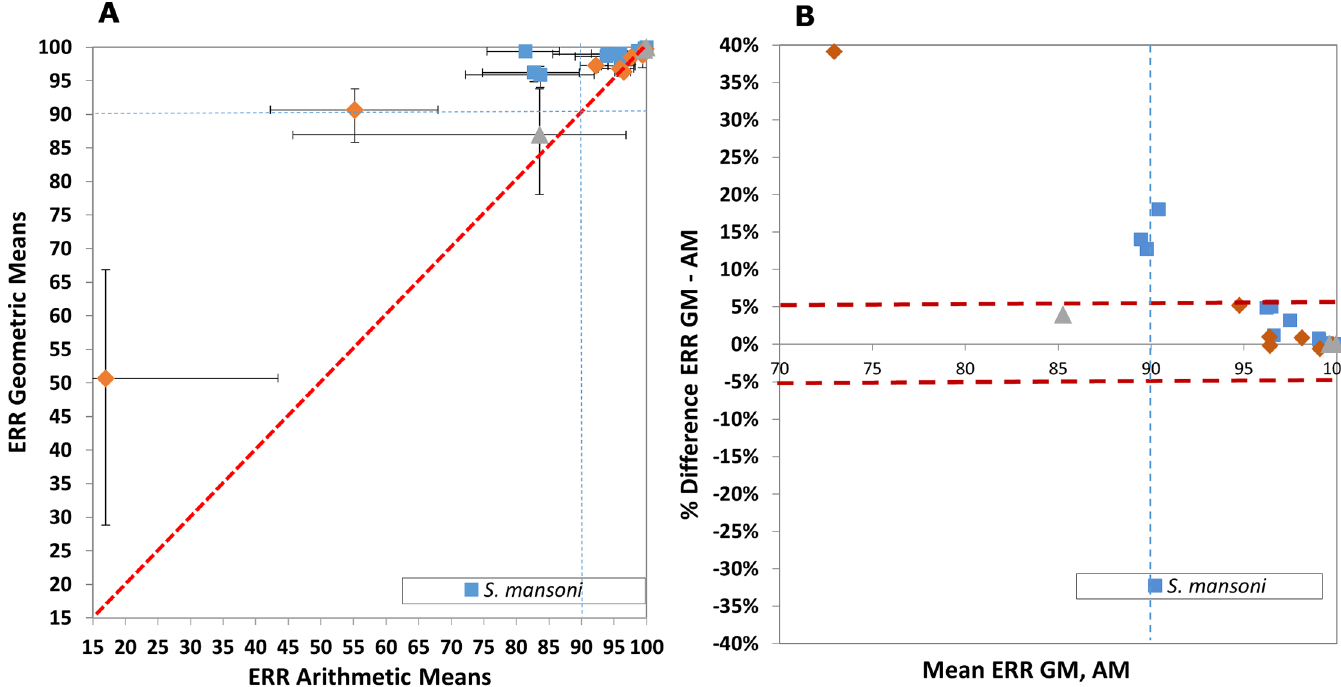
Fig 2. Comparison of egg reduction rate calculated as arithmetic mean (ERR AM ) versus geometric mean (ERR GM ), both with estimated 95% confidence intervals (CIs). A. L ’ Abbé plot, B. Bland & Altman plot. For each point, the 95% CIs are shown in the L ’ Abbé plot, where the red dashed diagonal line of no difference between the ERR calculated with both metrics. The blue dashed line represents the threshold for acceptable efficacy defined by WHO [3].